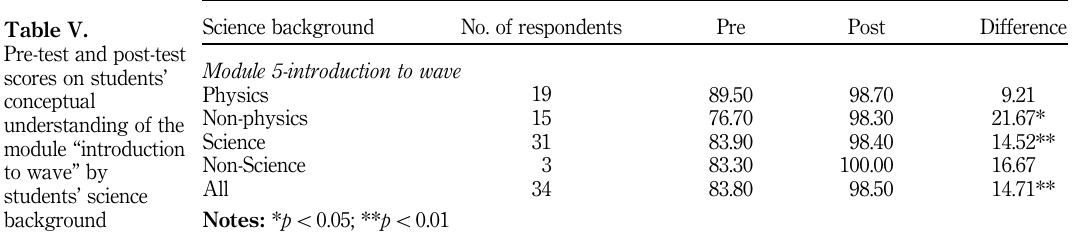
Table V. Pre-test and post-test scores on students ’ conceptual understanding of the module “ introduction to wave ” by students ’ science